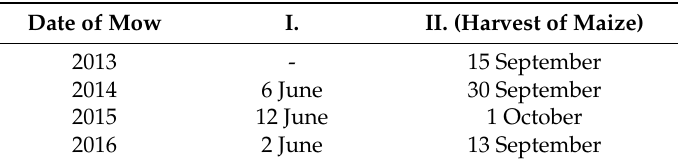
Table 12. Dates of mow of perennial crops and maize.